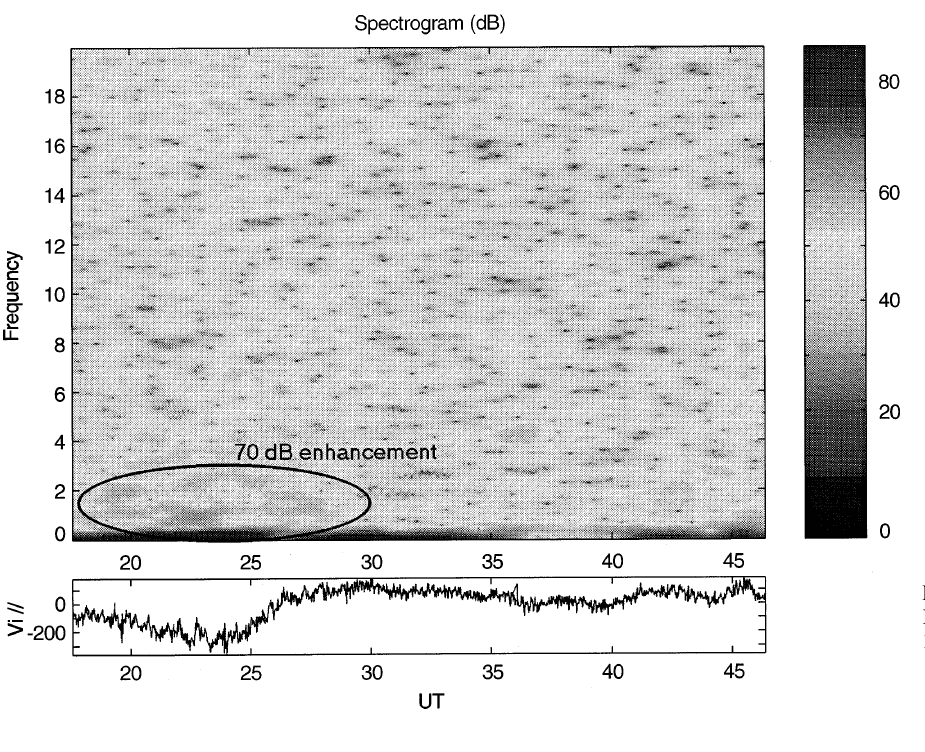
Fig. 16. Spectrogram of the 30 March 1992 experiment (altitude 190.5 km); frequencies are in h (cid:126)(cid:49)